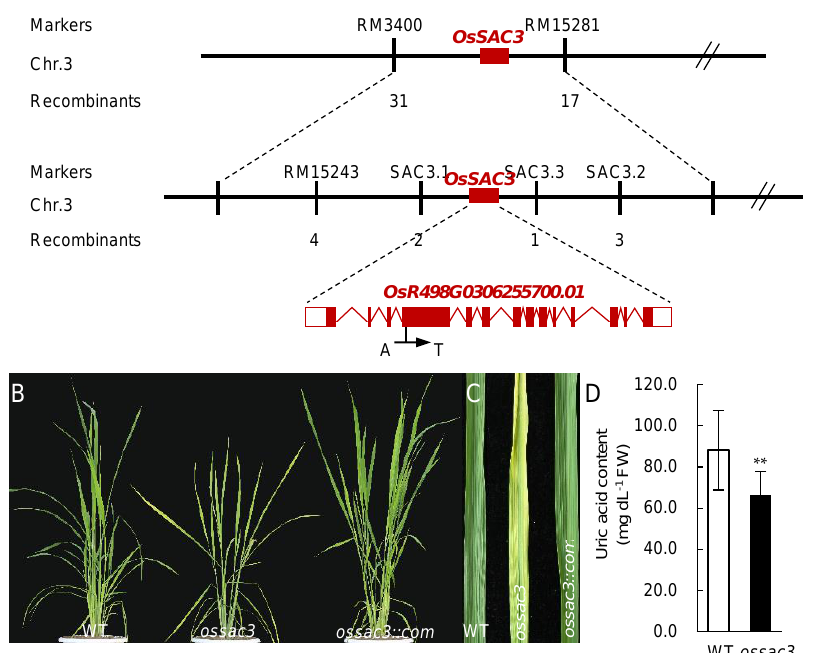
Figure 1. Map-based clone and identification of OsSAC3 . ( A ): Map-based clone of OsSAC3 ; ( B , C ): Complementation of ossac3 mutants with the wild-type OsSAC3 genomic fragments; ( D ): Measurement of uric acid content between the wild type and the ossac3 mutants. Decreased uric acid was observed in the ossac 3′ s leaves than that of the wild type. ** p < 0.001 determined by Student’s t − test.